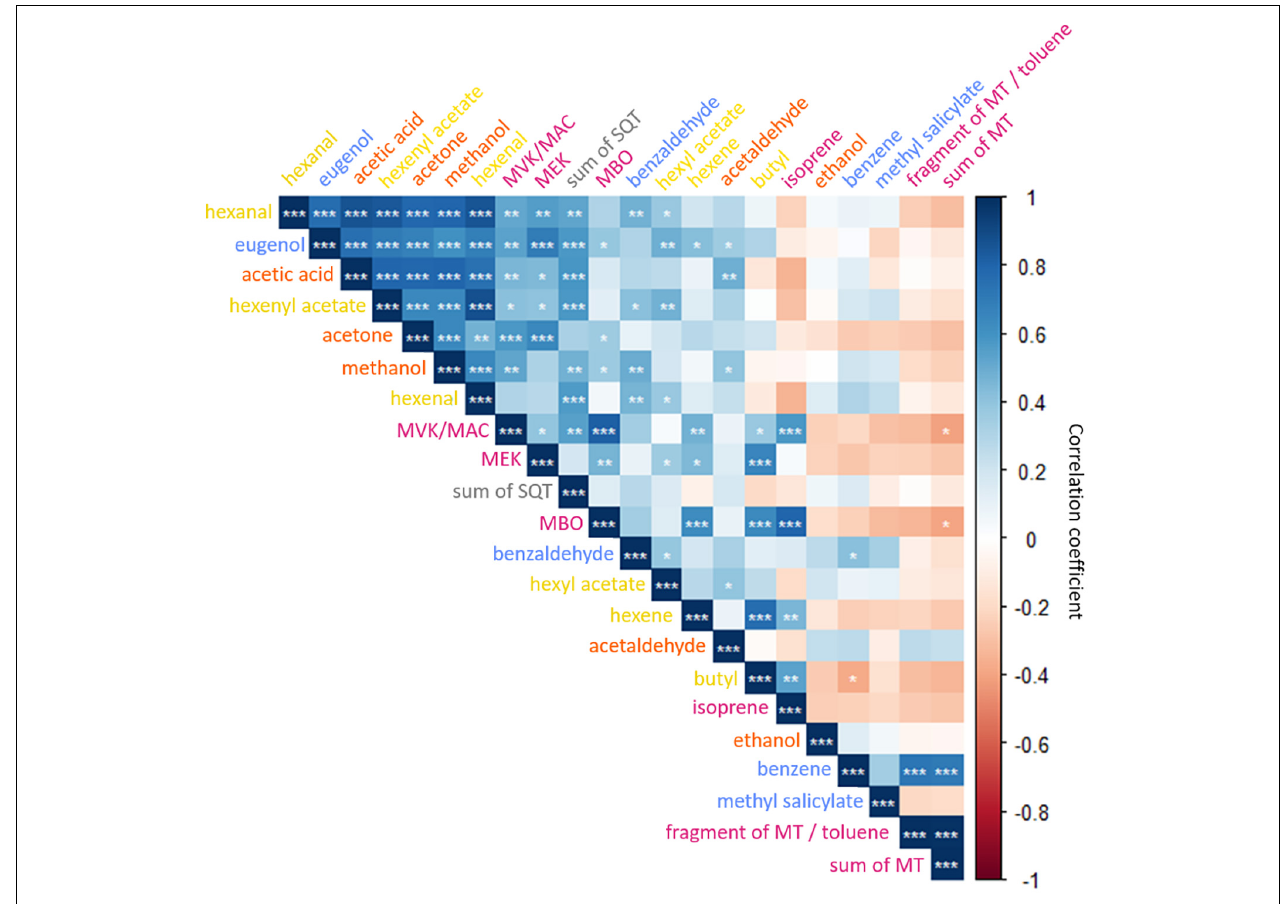
FIGURE 4 | Matrix of Pearson correlation coefficients of 22 m/z assigned to constitutive VOCs of Q. robur , F. sylvatica , B. pendula , and C. betulus seedlings. Levels of significance among positive (blue) and negative (red) correlations are indicated as * p < 0.05, ** p < 0.01, *** p < 0.001. ISO, isoprene; MBO, 2-methyl-3-buten-2-ol; MVK, methyl vinyl ketone; MAC, methacrolein; MEK, methyl ethyl ketone; MT, monoterpenes; SQT, sesquiterpenes. Color-code of VOC compounds indicates LOX (yellow), MEP (magenta), Shikimate (blue), and MVA (gray, i.e., SQT) pathways, and oxygenated VOCs